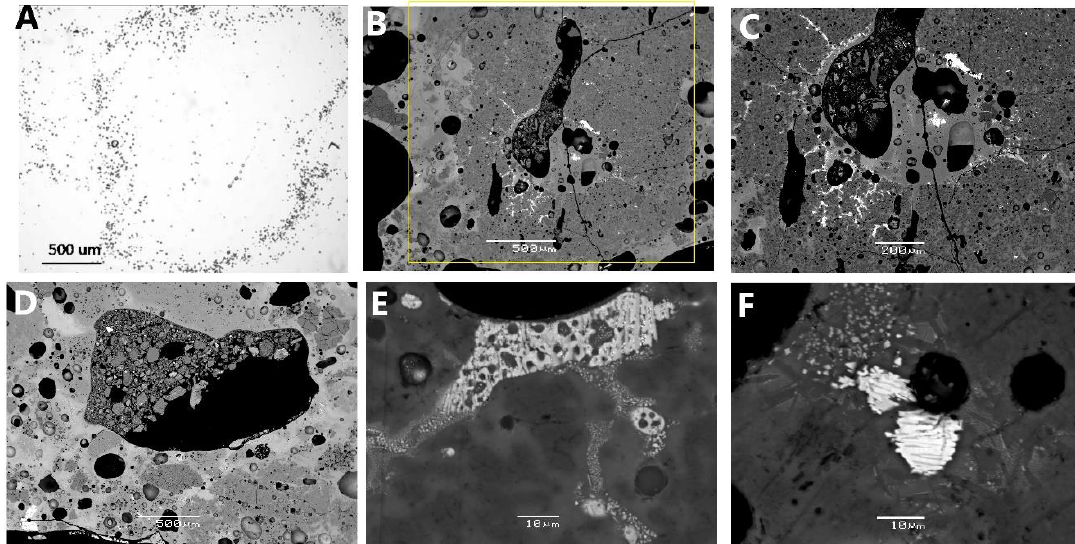
Figure 9. Pores and minerals in the ground glass sample HK-2a. ( A ) α -track image of a large quartz grain schematically marked by a yellow rectangle in SEM-BSE image ( B ). ( C ) Zoomed part of panel ( B ) showing abundant porosity of a metamorphosed mineral grain (see text for detail); white patches correspond to iron transport with expelled volatiles. ( D ) A pore filled with non-sintered material. ( E ) A destroyed ore mineral. ( F ) Ti-hematite intermixed with pseudobrookite; presumably, an ilmenite grain was a precursor.